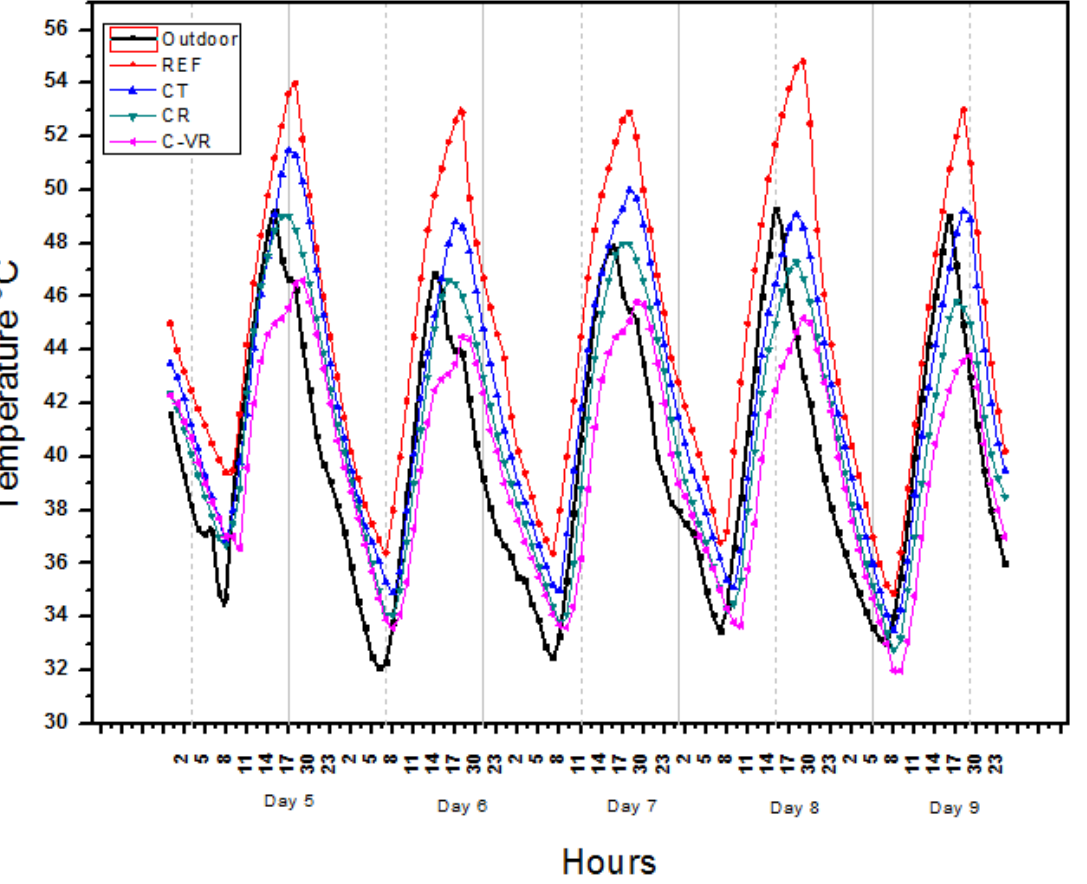
Figure 8. Indoor air temperature profiles of all the test cells from 5 – 9 July 2021.